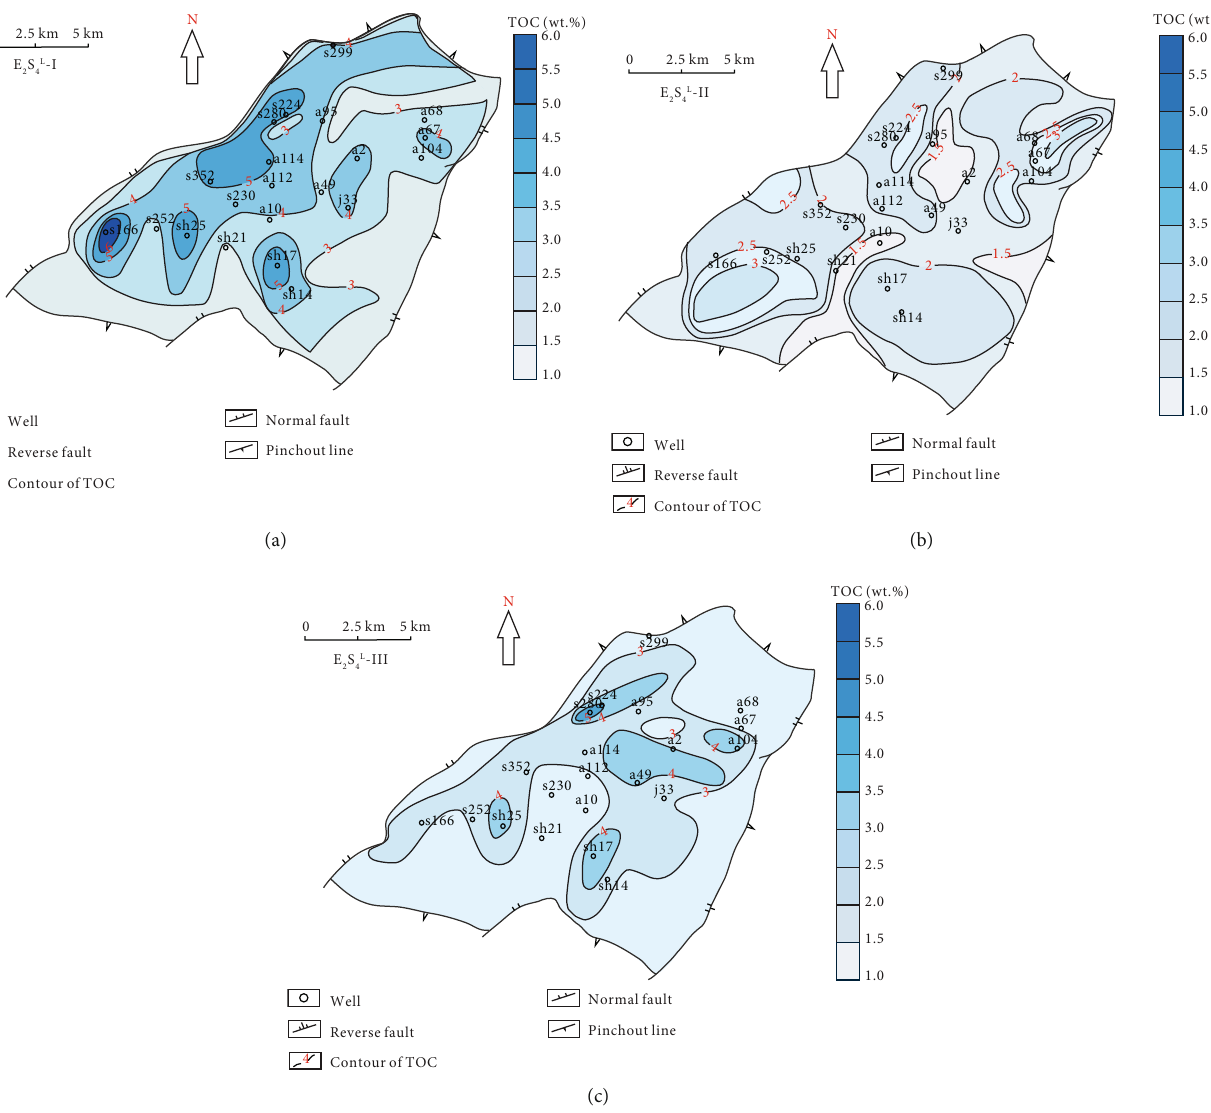
Figure 12: Contour maps of the predicted TOC content: (a) E